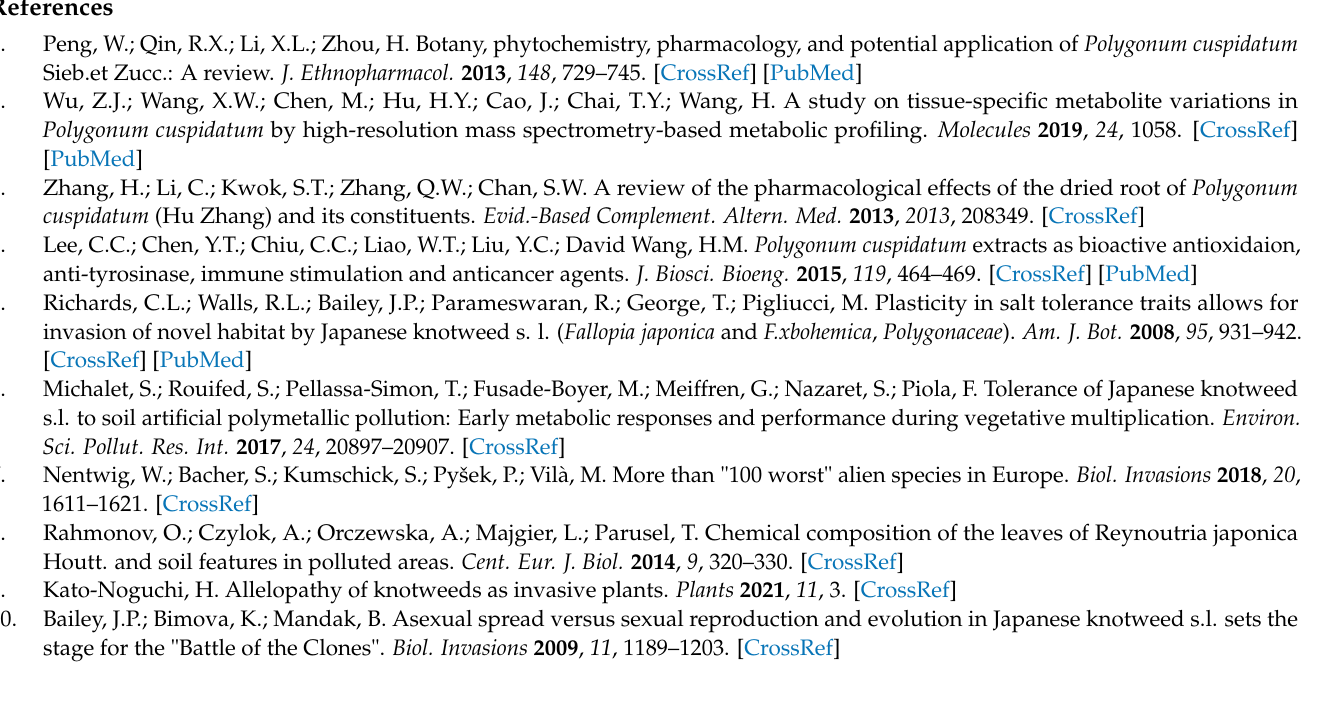
Table S1: the sequencing depth of three R. japonica , Table S2: comparison of the complete chloroplast genomes for 13 R. japonica , Table S3: the RSCU values of 13 R. japonica , Table S4: the codon usage of 13 R. japonica